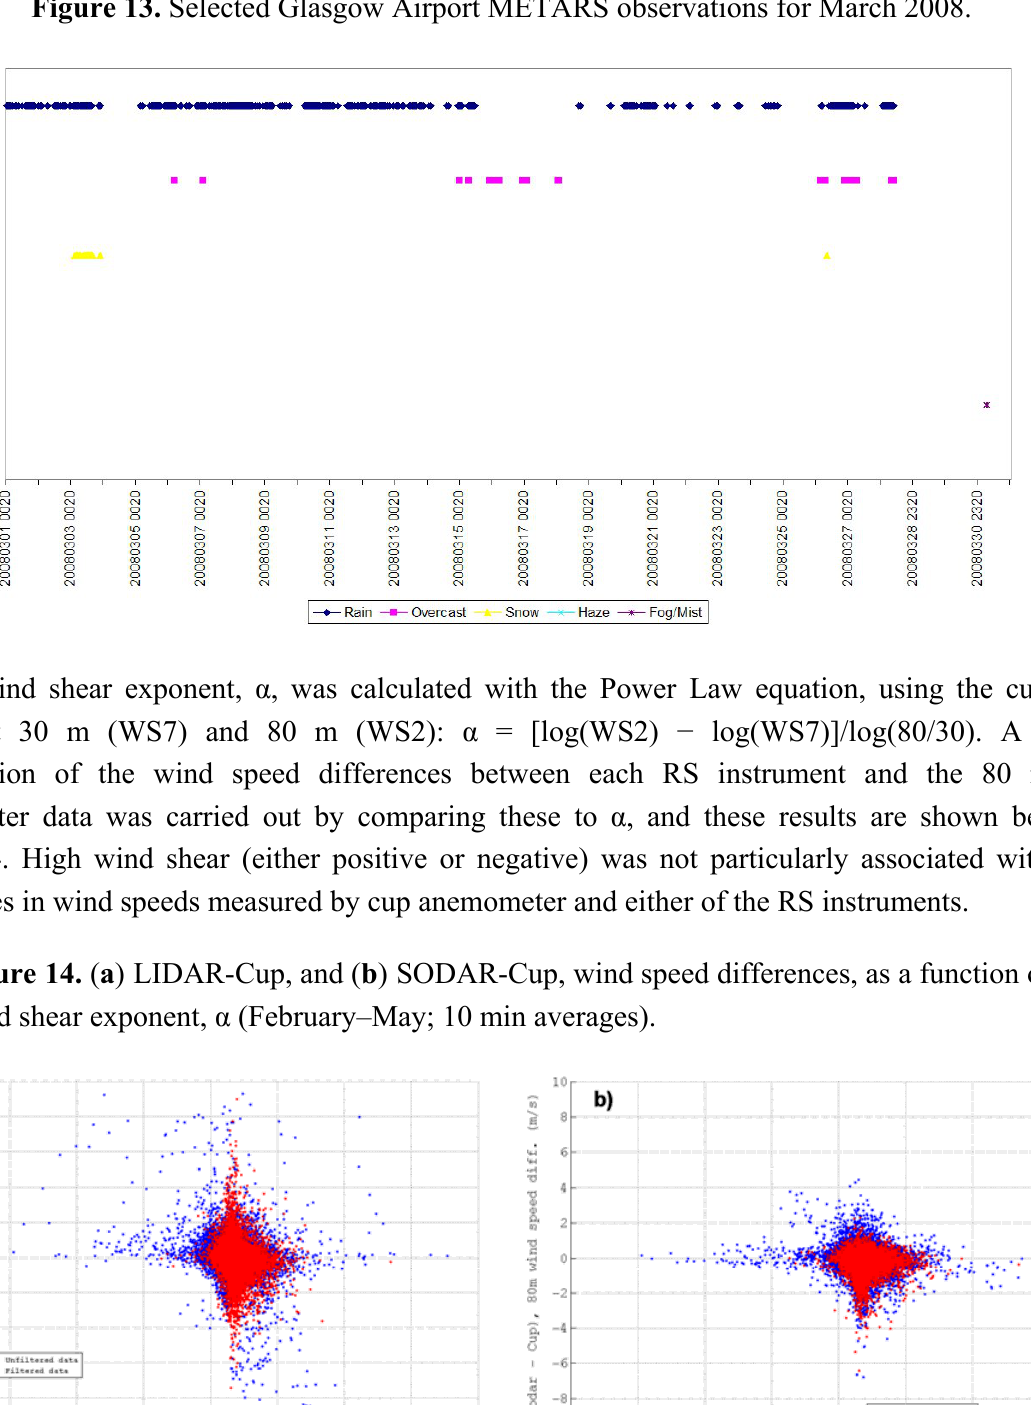
Figure 13. Selected Glasgow Airport METARS observations for March 2008.